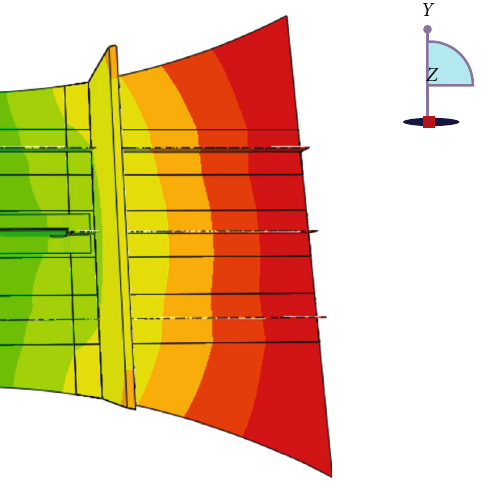
Figure 16: Standard analysis repaired panel in-plane displacement